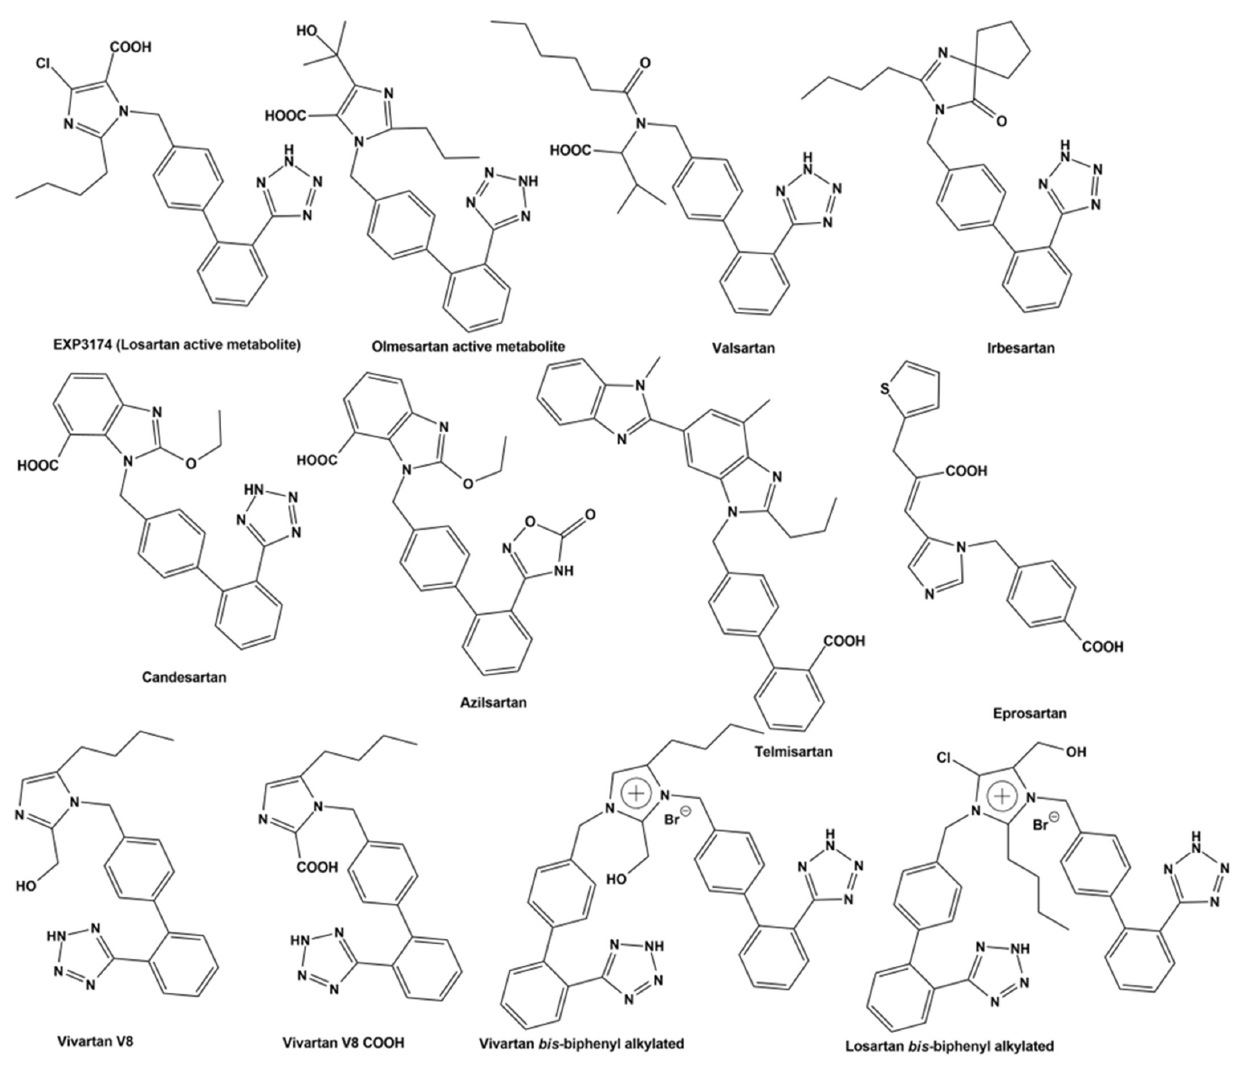
Figure 5. Structures of sartans. Chemical structures of losartan (EXP3174), olmesartan, valsartan, irbesartan, candesartan, azilsartan, telmisartan and eprosartan . Five of the eight ARBs share a common biphenyl-tetrazole scaffold structure. Azilsartan contains a biphenyl-oxadiazole scaffold. Telmisartan and eprosartan do not belong to the class of biphenyl-tetrazole ARBs. All sartans bear a negative charge (tetrazole and/or carboxylate) [57,76]. Compound V8 was designed and synthesized with the reorientation of the alkyl group and hydroxymethyl group in losartan at the laboratory of PML (Peptide Mimetic Limited) in Canada in the 1990s. The synthesis of V8 was optimized in the laboratory of Eldrug in Patras Science Park, Greece. Vivartan with similar activity as losartan did not reach clinical trials after its synthesis in 1993, as it was not cost-effective at that time. Currently, the synthesis of vivartan is efficient. Losartan and V8 were bi-biphenyl alkylated in an efficient method, providing a new class of ARBs with both imidazole nitrogens to be alkylated by biphenyl tetrazole [66,77] .